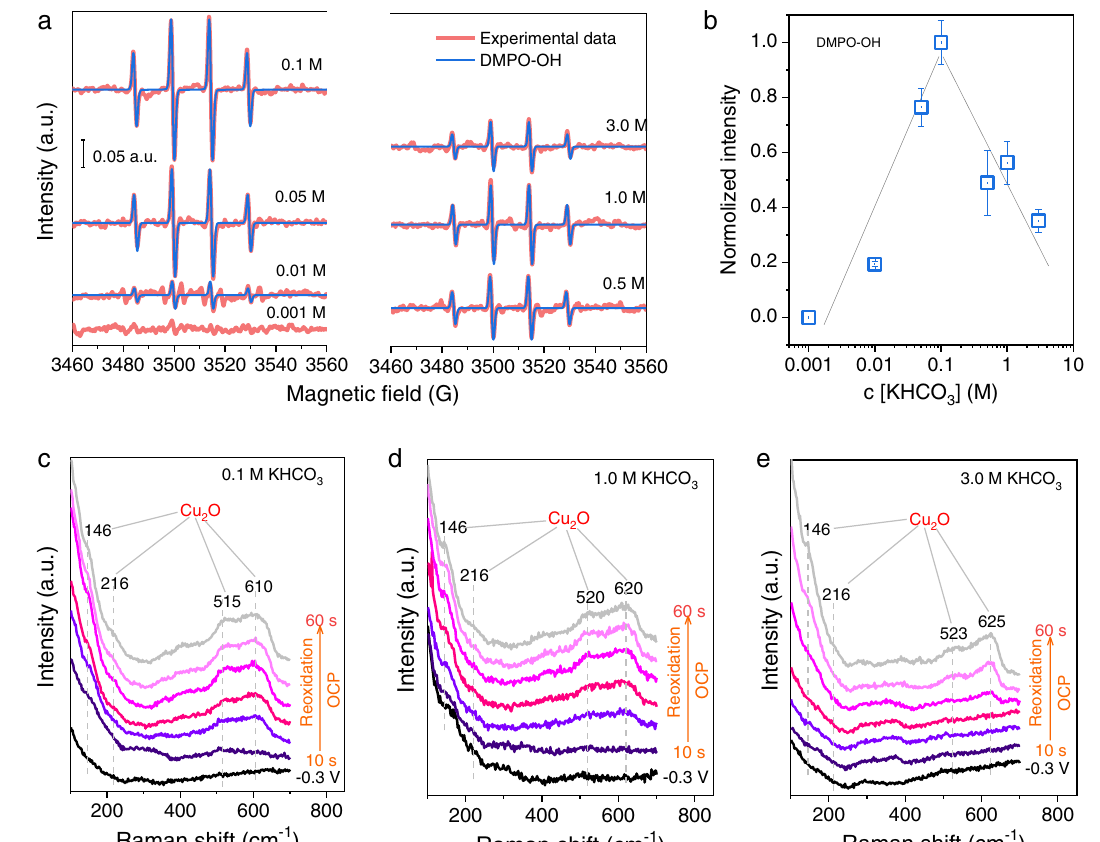
Fig. 5 Relationships between HCO 3 − concentration, OH (cid:129) radical amount, and reoxidation dynamics of OD-Cu electrodes. a The acquired EPR spectra in different HCO 3 − concentrations. Each solution contains 100 mM DMPO. b Correspondingly, the normalized intensity of DMPO-OH versus HCO 3 − concentration. The intensity was normalized by that of 0.1 M HCO 3 − . The gray lines guide the trends of DMPO-OH intensity without the compensation of K + . The error bars represent the standard deviation. c – e Raman spectra of OD-Cu reoxidation in different KHCO 3 concentrations at OCP after reduction at − 0.3 V RHE